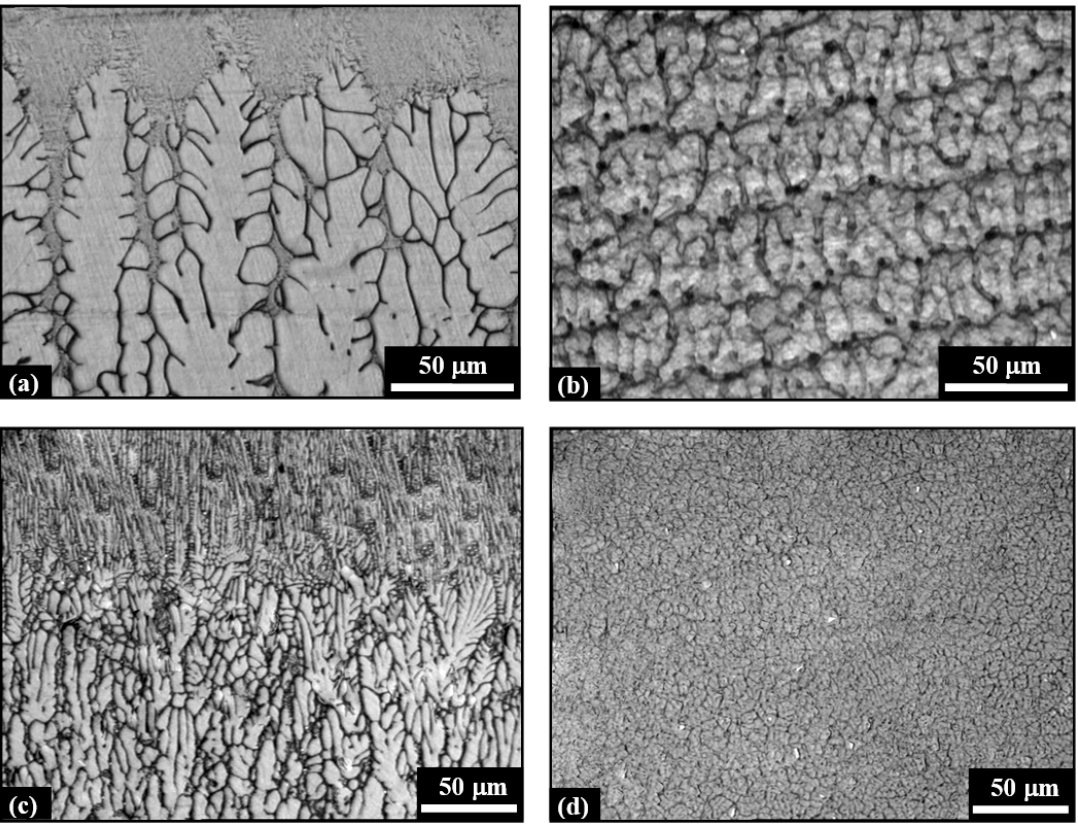
Figure 4. Microstructures of the directionally solidified Sn–10.2 Sb peritectic alloy: (a) longitudinal section; (b) transverse section ( G =4.5 K. mm -1 , V = 26.7 µm. s -1 ); (c) longitudinal section; (d) transverse section ( G =4.5 K. mm -1 , V = 266.7 µm. s -1 ) Table 1. The relationships between the dendritic spacings (λ Relationship Constant (k) Correlation coefficient